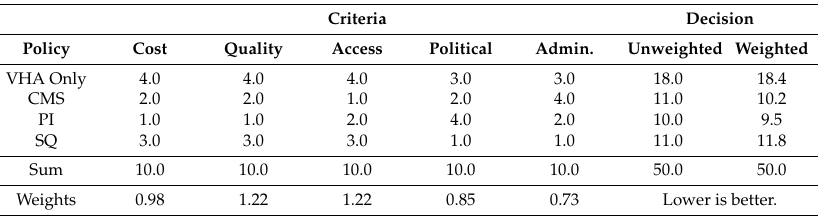
Table 4. Evaluation and comparison of possible policy interventions is depicted. The unweighted and weighted recommendations are initially identical without sensitivity analysis and in favor of the TRICARE